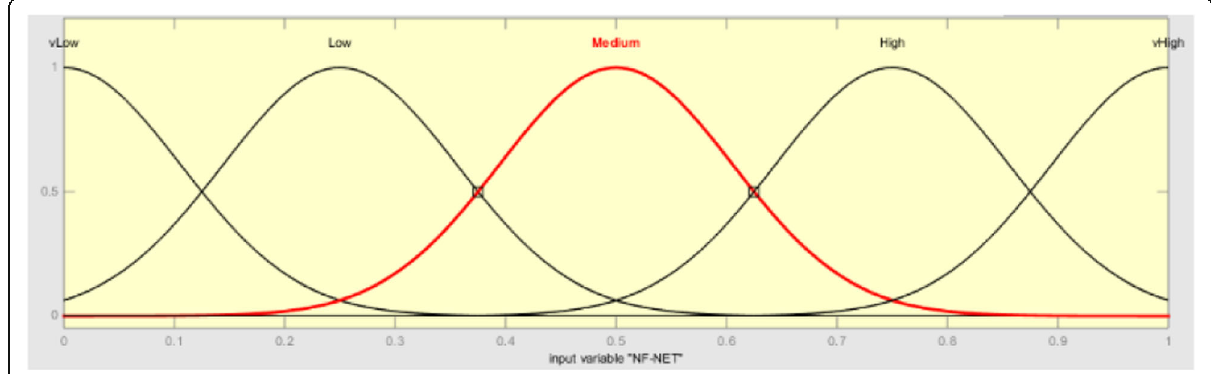
Fig. 3 Second input variable “ Normalized Network Frequency ”